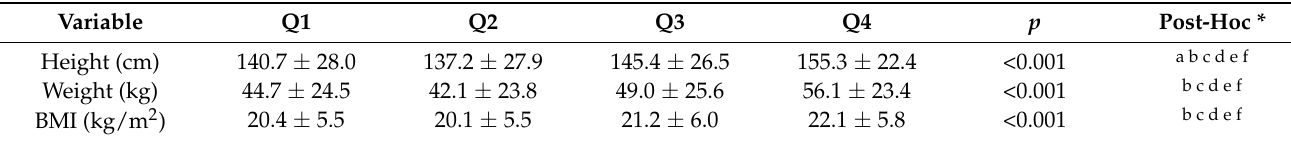
Table 2. Body measures across creatine